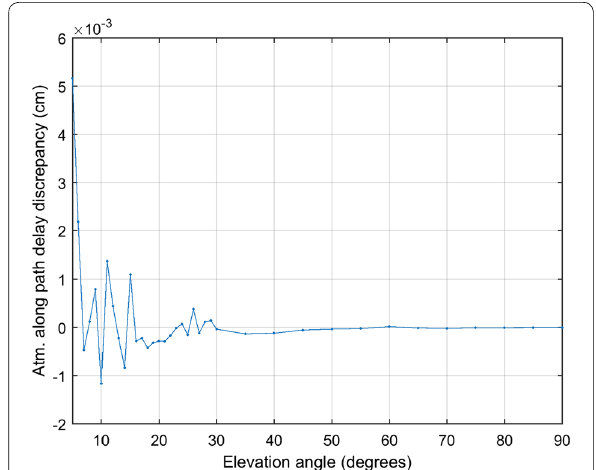
Fig. 7 Discrepancy in interferometric atmospheric along‑path delay between RM and RI formulations as a function of satellite elevation angle (for a fixed 10‑m reflector height)